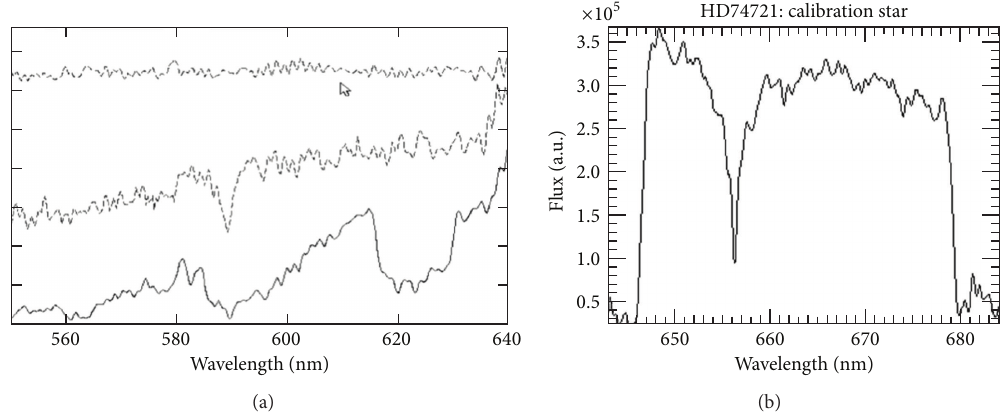
Figure 11: (a) Spectra of the 15th magnitude stars in the field of the planetary nebula M27; from top to bottom: the central white dwarf (featureless, as expected, in this wavelength range), a solar-type star with the NaD 5890, 96 lines, and an M star showing TiO bands. (b) Spectrum of the standard horizontal branch A-star HD 74721 used to flux-calibrate the NGC 628 data cube (see